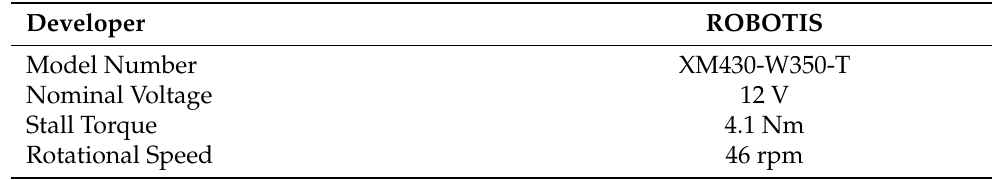
Table 2. Specifications of XM430-W350-T.